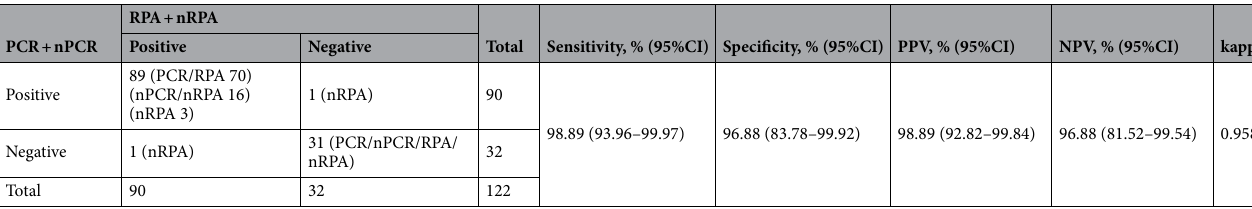
Table 3. Comparison of RPA plus nRPA with PCR plus nPCR for FeLV provirus detection in clinical samples.